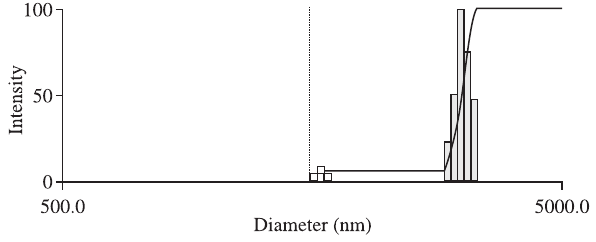
Figure 6. Results of Dynamic light Scattering of Sample B1L100.